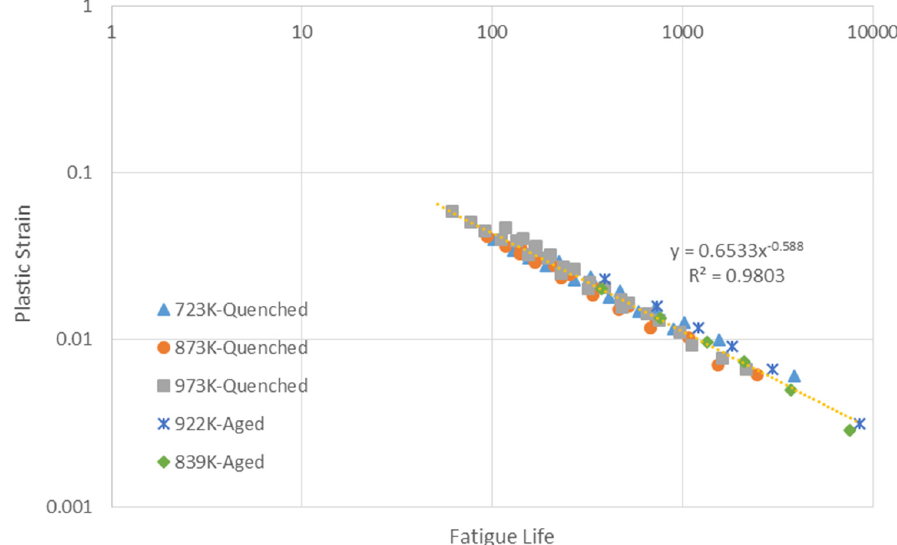
Figure 7. Transformed ε p, ref – N data of quenched and aged stainless steel 316 using Equation (14) with creep function c ( T , t , ε p ).